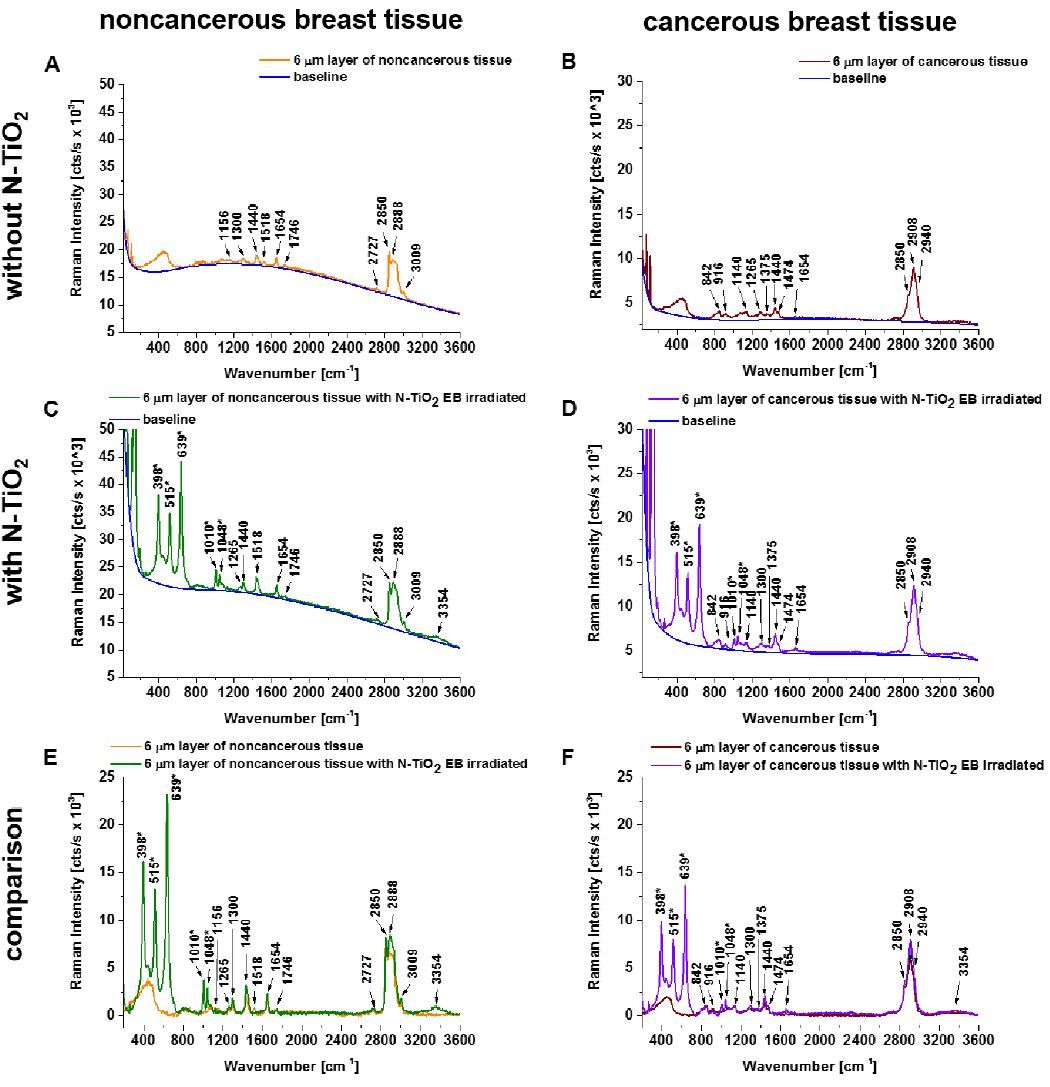
Figure 3. Raman spectra of infiltrating ductal carcinoma (6 µm slice) with and without the addition of N-doped TiO 2 (N:Ti = 1:1) nanoparticles electron beam-irradiated with a dose of 500 kGy. Subsets ( E ) and ( F ) show a comparison of Raman spectra after background subtraction marked in blue lines on raw Raman spectra ( A – D ). Raman bands attributed to N-doped TiO 2 EB-irradiated NPs are marked with an asterisk (*).